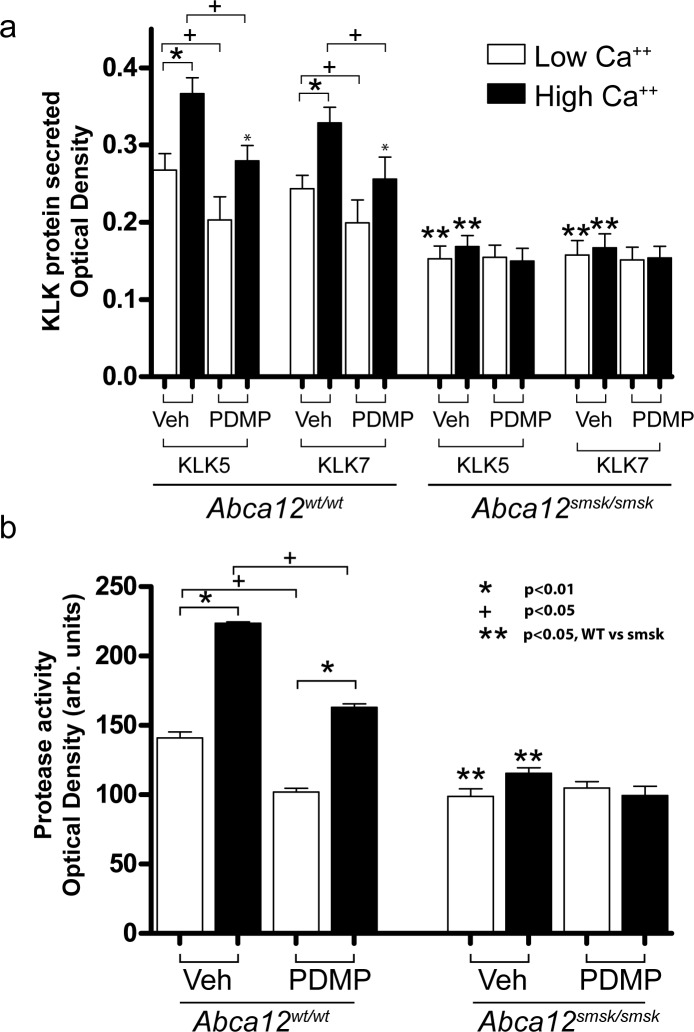
Inhibition of glucosylceramide production mimics defects in KALLIKREIN secretion from cultured Abca12smsk/smsk keratinocytes.(a) Secretion of KLKs into the culture media from cultured keratinocytes were measured via ELISA. Basal levels of KLK5 and -7 were readily detected in the culture media of keratinocytes grown under low Ca++ conditions, and this increased after differentiation induced by elevated Ca++ levels (p<0.01 for both KLK5 and -7). Pre-treating WT keratinocytes with d,l-threo-1-phenyl-2-decanoylamino-3-morpholino-1-propanolhydro-chloride (PDMP) significantly reduced secreted KLK5, -7 levels (p<0.05). Note that levels of KLKs in the media of Abca12smsk/smsk cells remained unaffected by Ca++ or PDMP treatment. Both KLK and protease activity in smsk keratinocytes were lower than WT (**, p<0.05). (b) Protease activity was measured in the conditioned media from WT or Abca12smsk/smsk keratinocytes. Similar to secreted KLK levels, protease activity in WT cells was elevated after Ca++ differentiation (p<0.05) and suppressed by PDMP pretreatment. In contrast, protease activity in the cultured media remained unaffected in Abca12smsk/smsk keratinocytes either after differentiation or PDMP treatment. Sample size n = 3 was used for each condition tested.